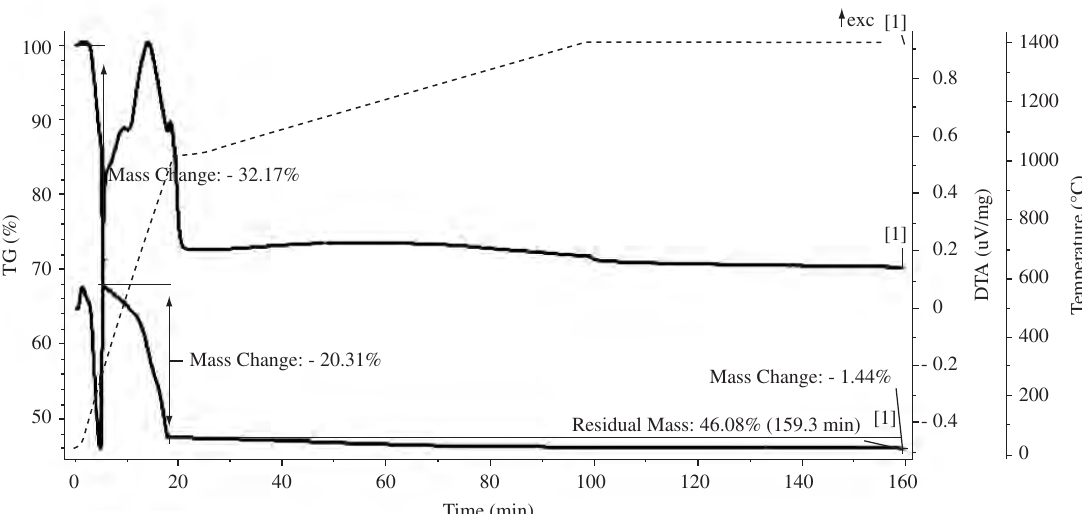
Figure 1. TGA-DTA graph of a sample of coprecipitated triple hydroxide (------ temperature, DTA, TGA).